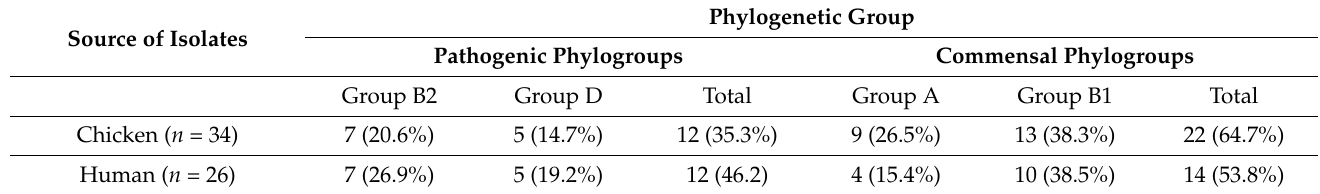
Table 1. Frequency distribution of phylogenetic groups among the examined E. coli isolates from chicken and human.